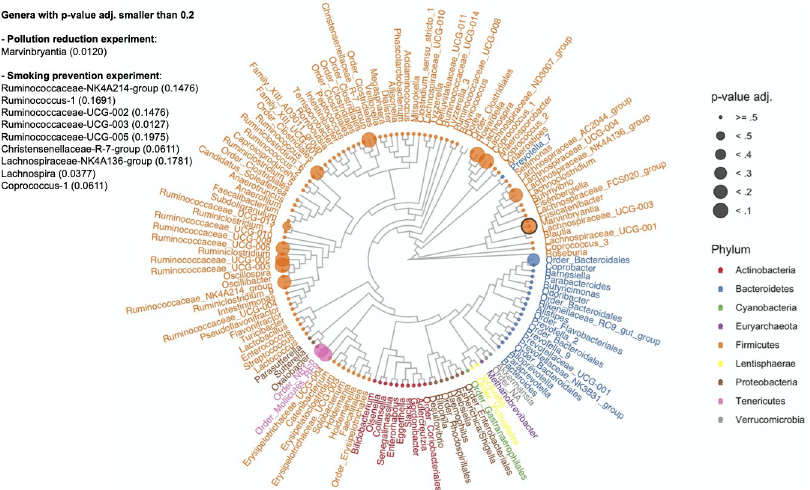
Fig 3. Differential abundance. For each genus, adjusted two-sided randomization-based p-values for 10,000 permutations of the smoking prevention intervention assignment following a matched-pair design. Genera with no tip point belong to the set of reference taxa. Black circled tip point: differentially abundant genus ( Marvinbryantia ) in the air pollution reduction experiment.